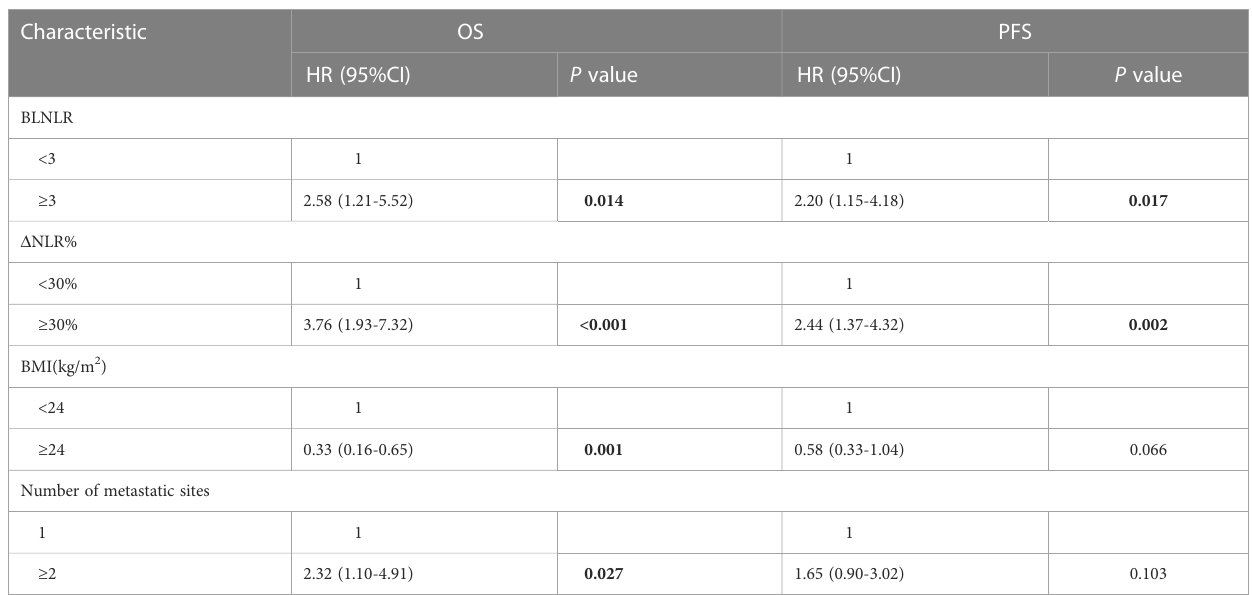
(Figure 2A). The median PFS of the low-BLNLR+ low- D NLR%